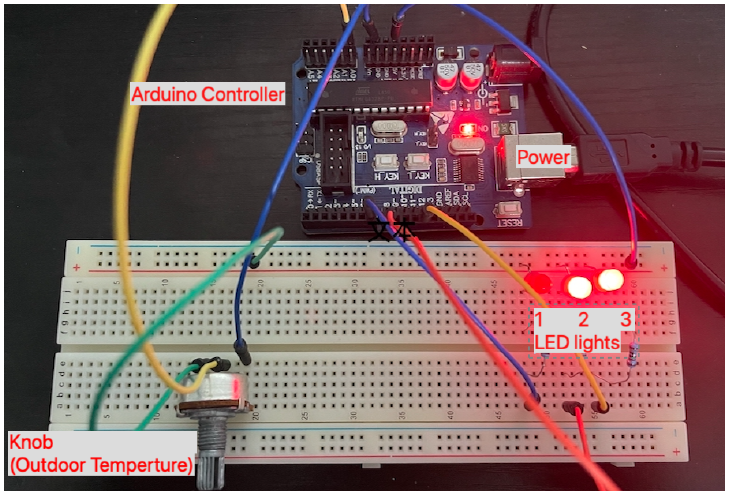
Figure 5. LED light 1 is Off without attacks.